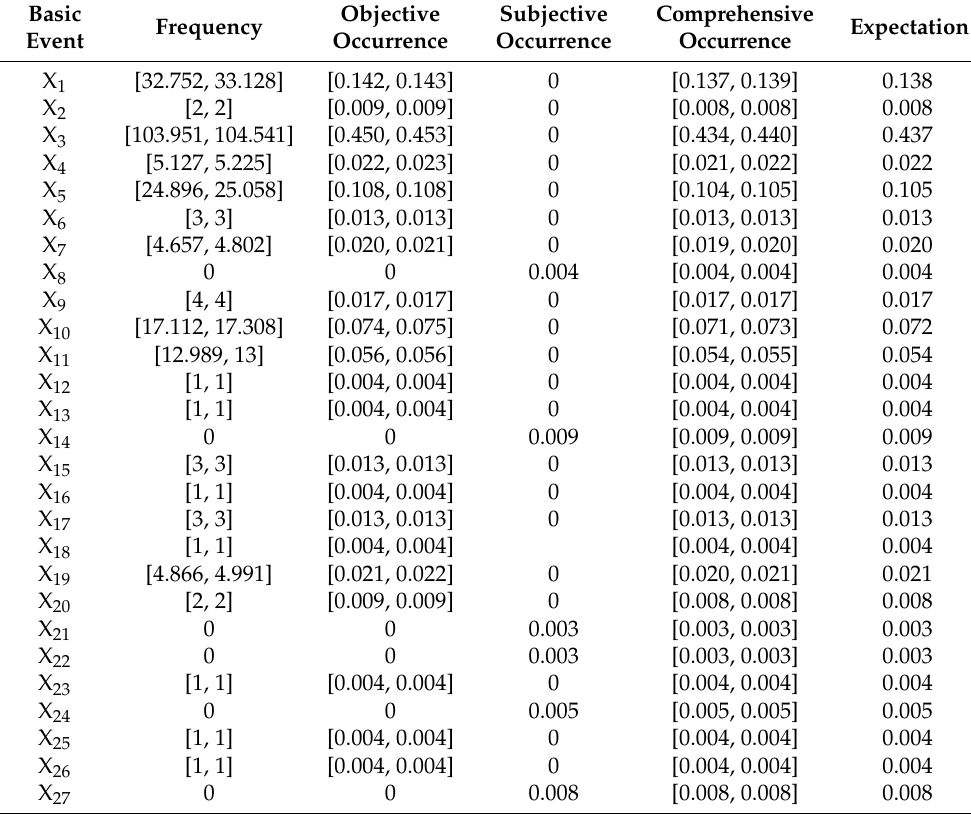
Table 14. Results of quantitative